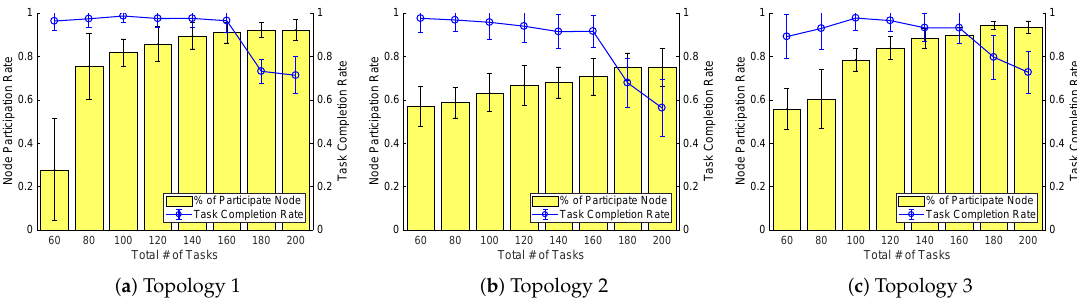
Figure 13. Fog node participation rate with respect to task intensity in three different node